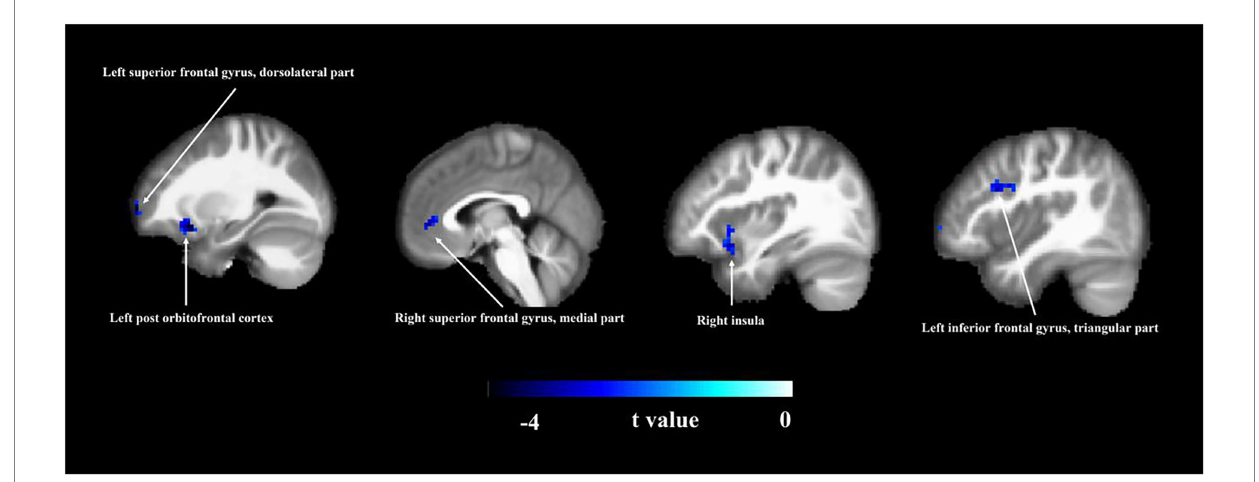
FIGURE 1 Amplitude of low-frequency fluctuation (ALFF) analysis. Brain region information of ALFF was compared between MCI and HC groups. The two- sample t -test was used to compare the groups. Areas in blue indicate significantly decreased ALFF values. Compared with the HCs, the MCI patients showed significantly decreased ALFF values in the left dorsolateral superior frontal gyrus, left post orbitofrontal cortex, right medial superior frontal gyrus, right insula, and left triangular inferior frontal gyrus. MCI, mild cognitive impairment; HC, healthy control.